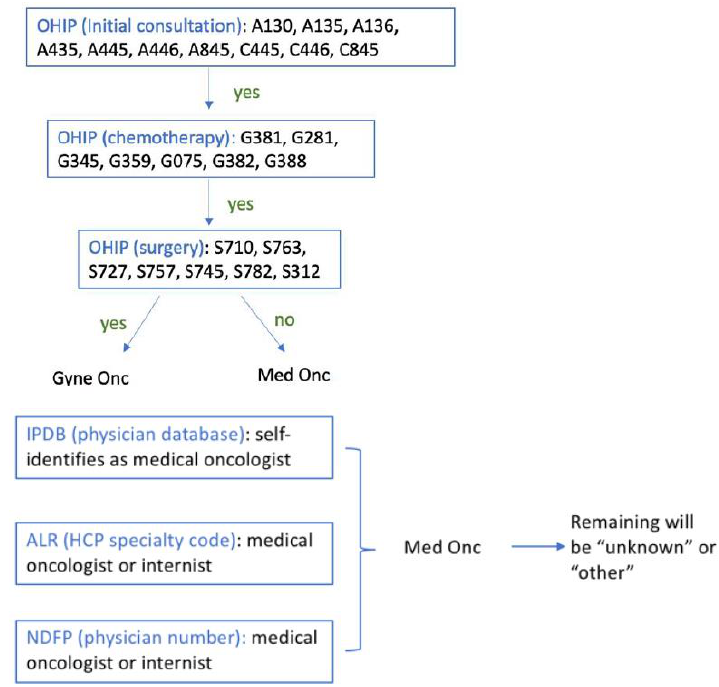
Figure A5. Definitions of providers of systemic therapy.